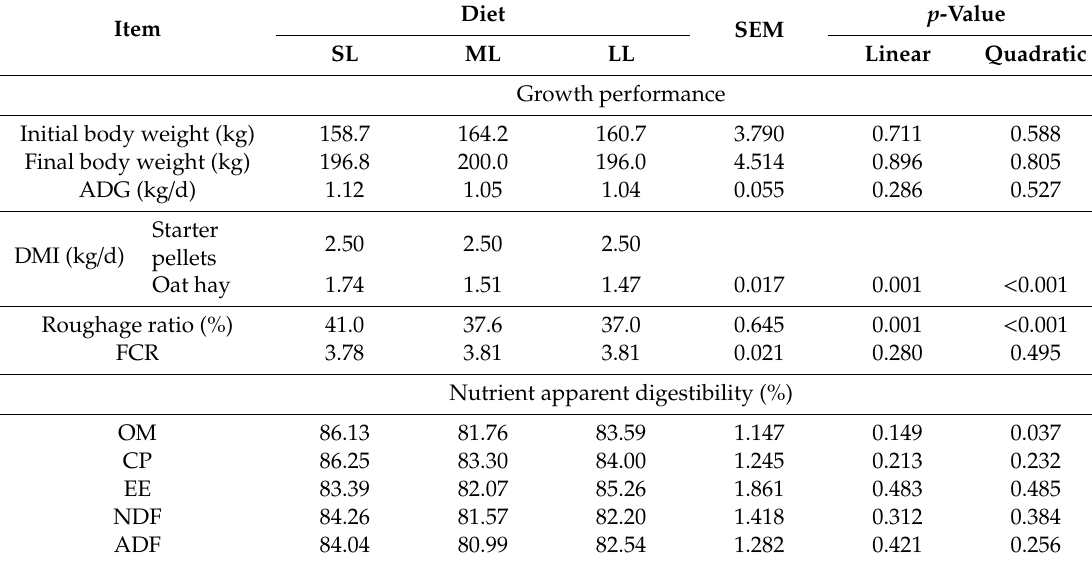
Table 2. E ff ects of roughage length on the growth performance and nutrient apparent digestibility of weaned